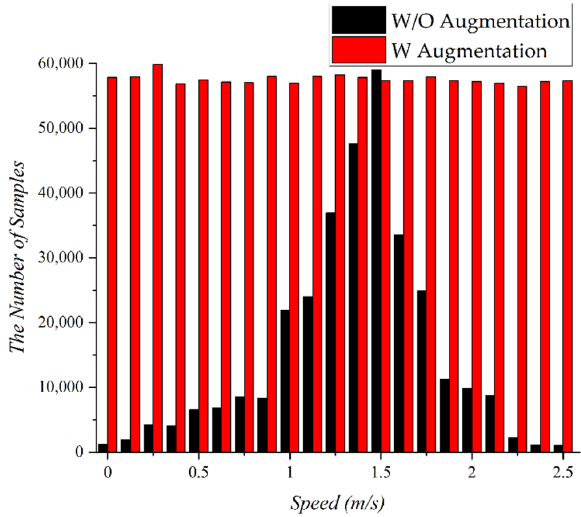
Figure 5. Original (black) and time-warped (red) moving speed data.